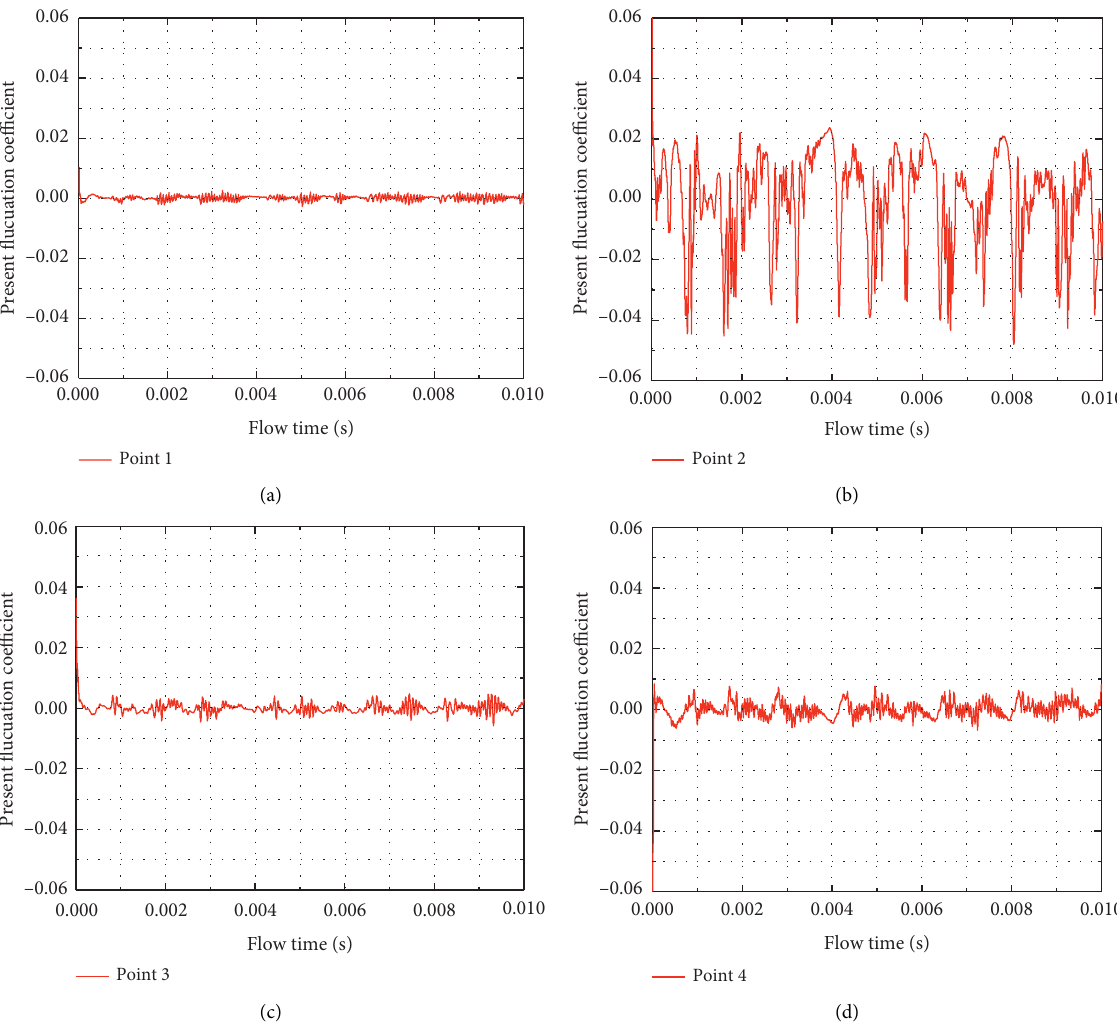
Figure 13: Pressure fluctuation coefficient at different monitoring points. (a) Initial jet port. (b) Vortex 1. (c) Secondary jet port. (d) Vortex